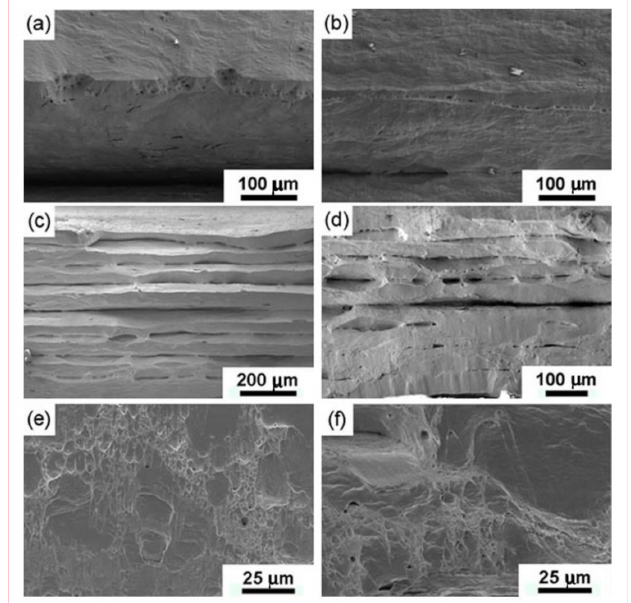
Figure 9. SEM micrographs of tensile fracture surfaces of Cu ARBed for ( a ) 1 pass, ( c ) 3 passes, and ( e ) 6 passes, and fracture surfaces of Cu ARBed for ( b ) 1 pass, ( d ) 3 passes, and ( f ) 6 passes after annealing 60 min at 300 ◦ C.